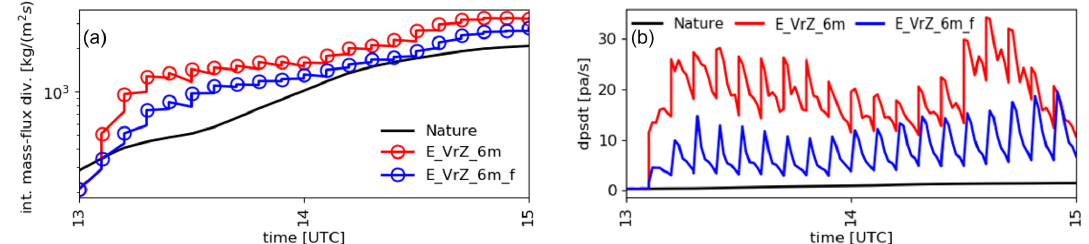
Figure 4. Domain-integrated mass-flux divergence of the analysis (indicated by circle) and background at each cycle (a) and domain-averaged surface pressure tendency at the analysis time and at each minute of model integration during the assimilation window (b) for E_VrZ_6m and E_VrZ_6m_f compared with those of the nature